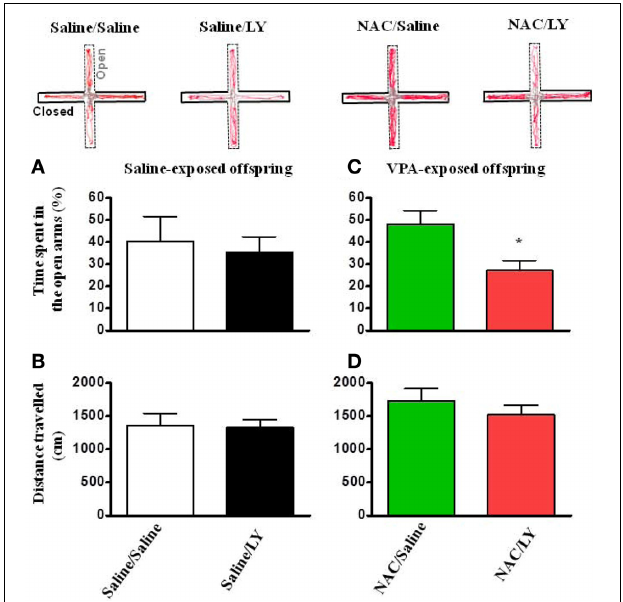
FIGURE 7 | NAC-mediated amelioration of anxiety in VPA-exposed offspring is blocked by mGluR2/3 antagonist. (A,B) Rats of saline-exposed offspring weaned at postnatal day 24 received an intra-amygdala injection of LY341495 (2 µ g/0.5 µ l per side) once per day for 5 days. Twenty-four hours later, the rats were administered the elevated plus-maze test. The time spent in the open arms (A) and the distance traveled (B) were measured for 5min. (C,D) Rats of VPA-exposed offspring weaned at postnatal day 21 were administered an intraperitoneal injection of NAC (150mg/kg) once per day for 8 days. At postnatal day 24, the rats received an intra-amygdala injection of LY341495 (2 µ g/0.5 µ l per side) 30min before NAC once per day for 4 days. Twenty-four hours after the last injection of NAC and LY341495, the rats were administered the elevated plus-maze test. The time spent in the open arms (C) and the distance traveled (D) were measured for 5min. ∗ p < 0 . 05 vs. NAC/Saline.